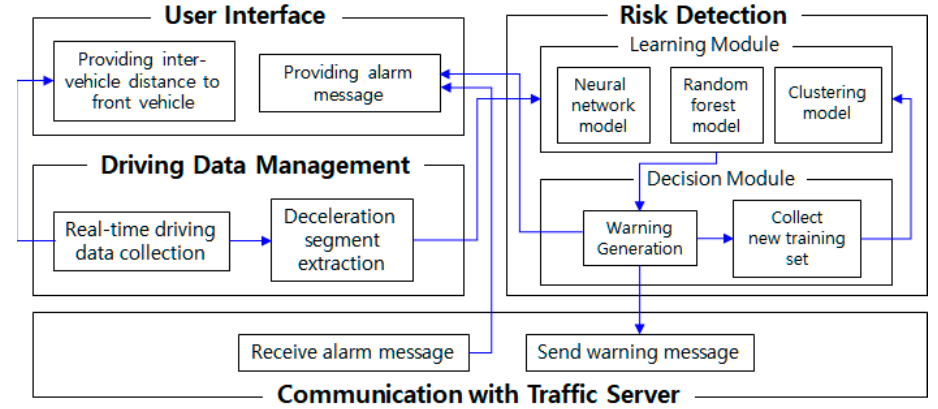
Figure 1. System Figure 1. System configuration.